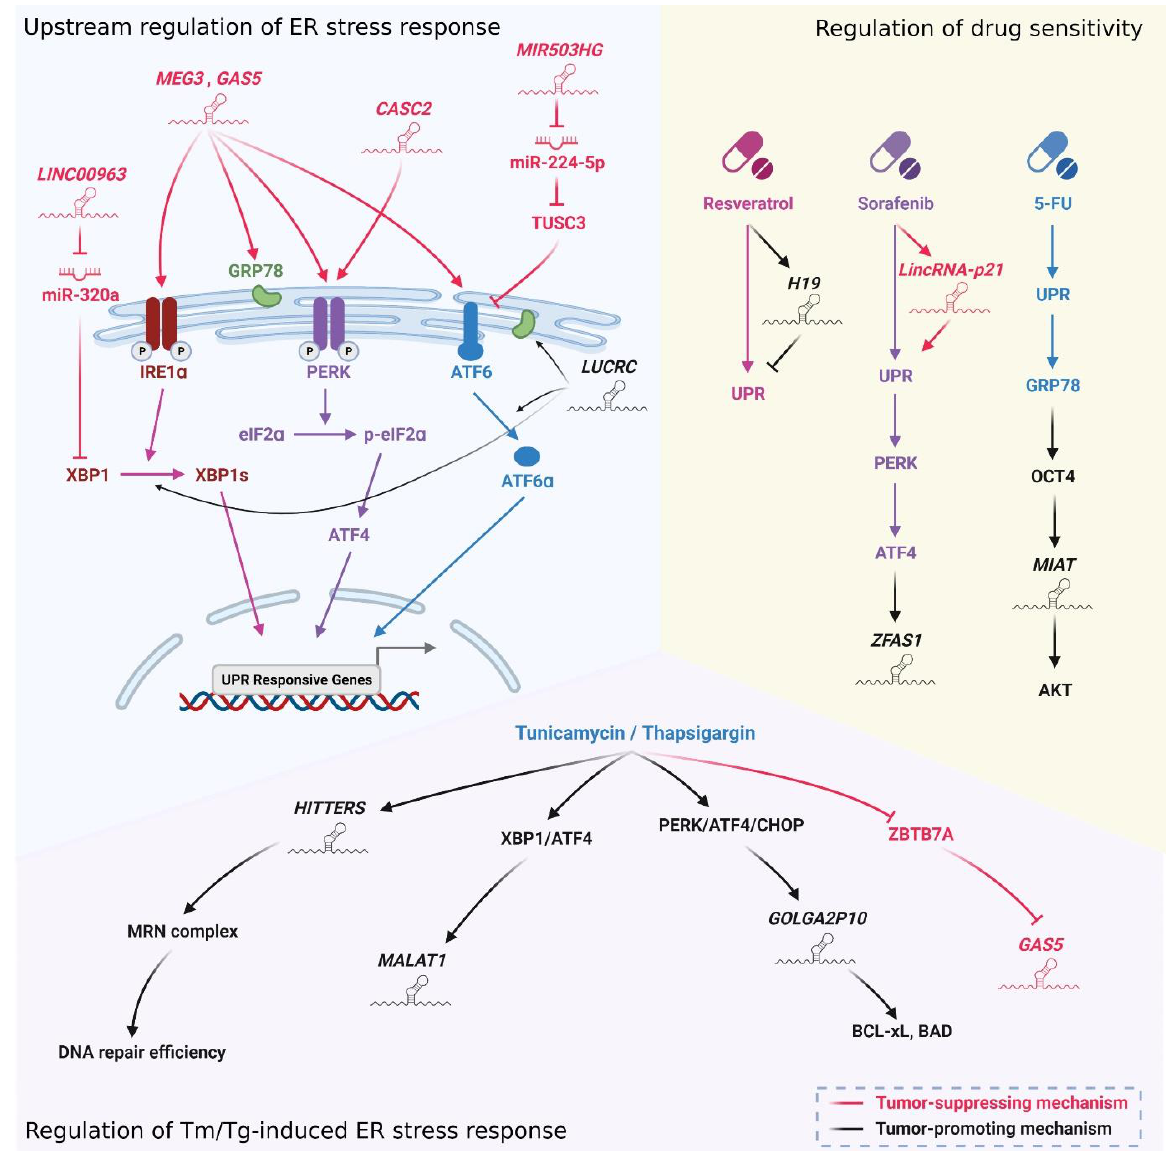
Figure 5. LncRNAs regulate the activation of ER stress response and the drug sensitivity to ER stress-inducing therapeutic agents. LncRNA LINC00963 , MEG3 , GAS5 , CASC2 , MIR503HG and LUCRC directly modulate UPR signaling to manage cell fate. Several chemotherapeutic drugs such as resveratrol, sorafenib and 5-FU increase lncRNA H19 and LincRNA-p21 expression to regulate UPR. In addition, these agents promote UPR signaling to upregulate ZFAS1 and MIAT and further affect drug sensitivity. A subset of lncRNAs, including HITTERS , MALAT1 , GOLGA2P10 and GAS5 , was induced by Tm/Tg-induced UPR to regulate tumor growth. XBP1 (X-box binding protein 1), IRE1 ɑ (inositol-requiring transmembrane kinase endoribonuclease- 1α), GRP78 (glucose -regulated protein), PERK (protein kinase-like ER kinase), eIF2 ɑ (eukaryotic translation initiation factor 2 subunit- α ), ATF4 (activating transcription factor 4), ATF6 (activating transcription factor 6), TUSC3 (tumor suppressor candidate 3), UPR (unfolded protein response), MRN complex (MRE11 – RAD50 – NBS1 complex), CHOP (C/EBP homologous protein), BCL-xL (B-cell lymphoma-extra large), BAD (BCL2 associated agonist of cell death) and ZBTB7A (zinc finger and BTB domain containing 7A). This figure was created with BioRender.com.